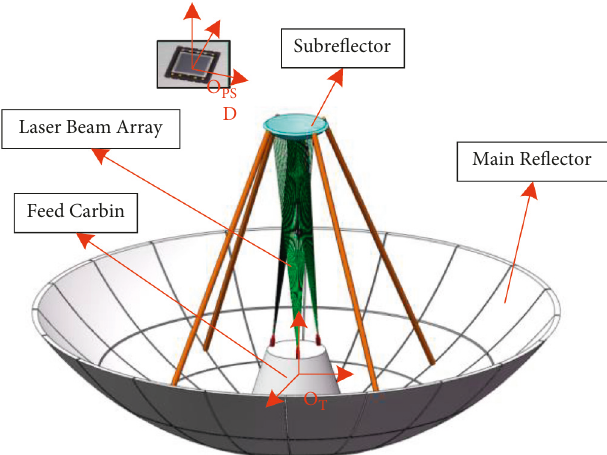
Figure 3: Schematic diagram of the laser array and PSD installation position.